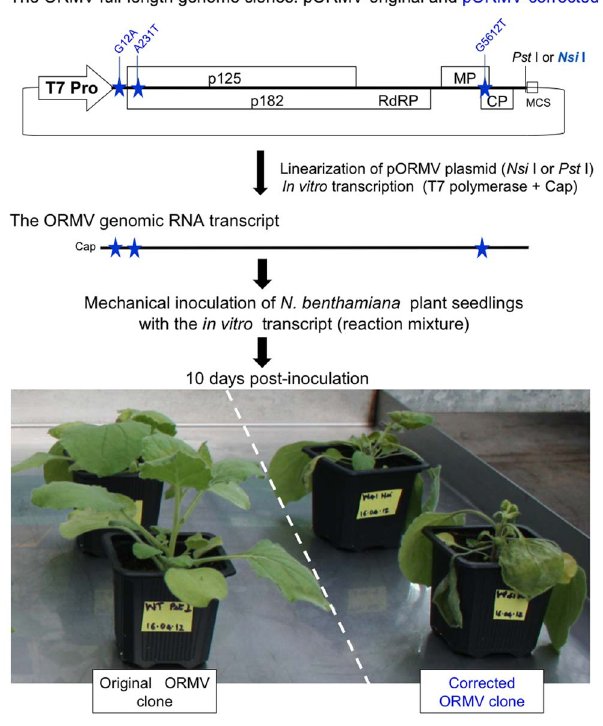
Figure 3. Test of the original and the corrected ORMV clones for infectivity. The plasmid containing the full-length ORMV genome sequence (original or corrected) behind the T7 promoter is depicted schematically: the restriction site Pst I or Nsi I, respectively, just downstream of the genome (located in multiple cloning site; MCS) was used for linearization of the plasmid, followed by run-off transcription by T7 polymerase in the presence of a cap analog. The resulting in vitro transcript (ORMV genomic RNA) was taken for mechanical inoculation of N. benthamiana plants. The picture shows the inoculated plants at 10 days post-inoculation.